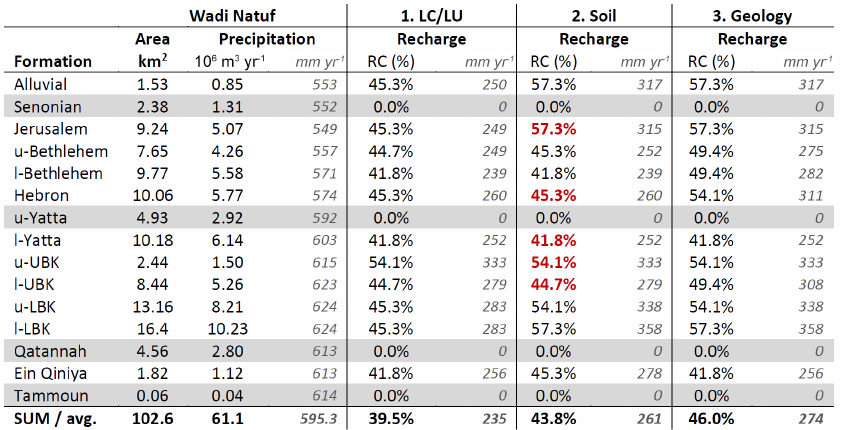
Table 4. Extrapolated recharge coefficients per